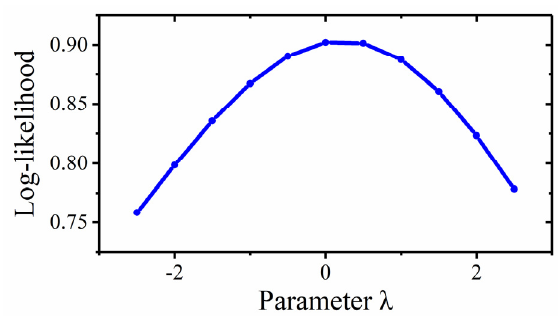
Figure 5. Log-likelihood function with parameter λ .